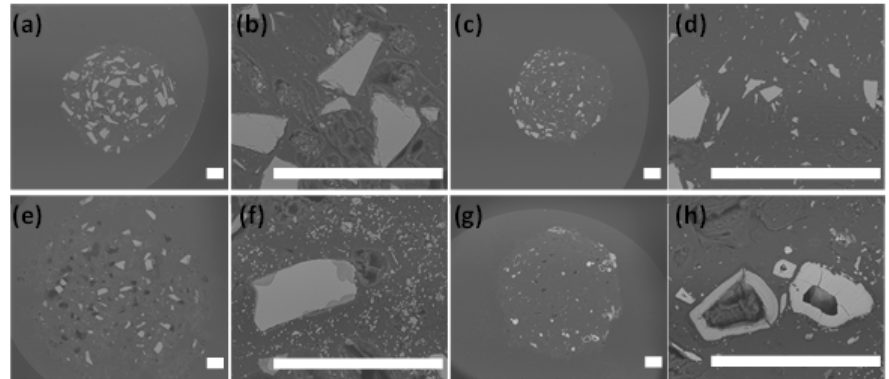
Figure 10. Scanning electron microscopy cross-sectional images of Si-BaG50 ( a , b ) before in vitro hydrolysis, ( e , f ) after 40 weeks in vitro and P-BaG35 ( c , d ) before hydrolysis and ( g , h ) after 40 weeks in vitro . Scale bar 200 µm.